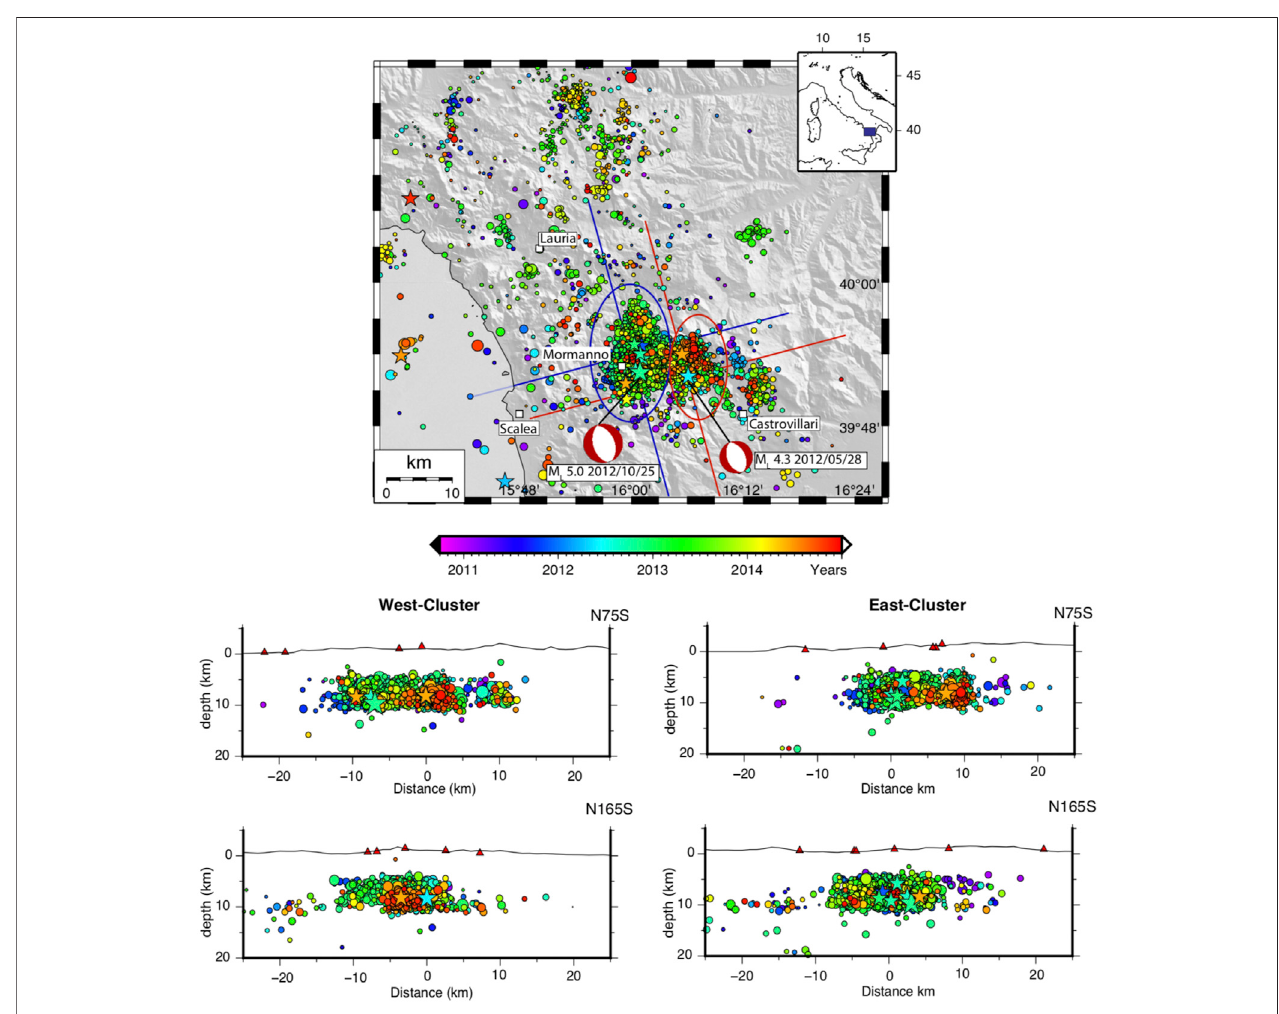
FIGURE 2 | Map and sections of the 2011 – 2014 seismic sequence/swarm from ISIDe Working Group (2016), https://doi.org/10.13127/ISIDE. The size of the epicenters is proportional to the magnitude and star symbols depict events having M > 3.5. The epicenters are divided into two main clusters: Western and Eastern, enhanced on the map by blue and red ellipses. The cross-sections of the Eastern and Western clusters are plotted to the bottom.